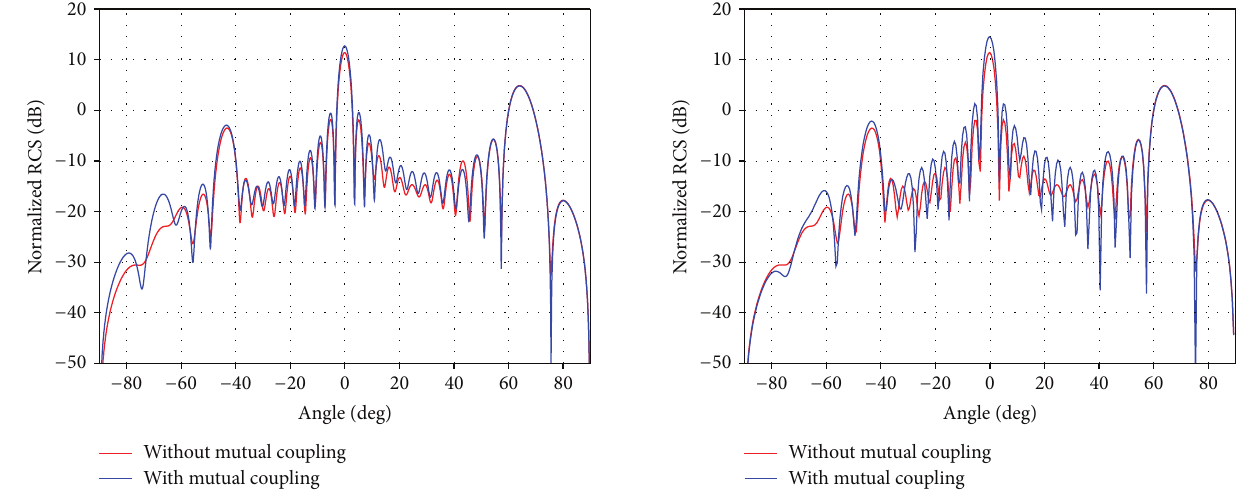
Figure14:RCSofa series-fedparallel-in-echelon linear dipolearray ( 𝑁 = 40 ) with Doplh-Chebyshev amplitude distribution ( 𝜃 𝑠 = 65 ∘ ).